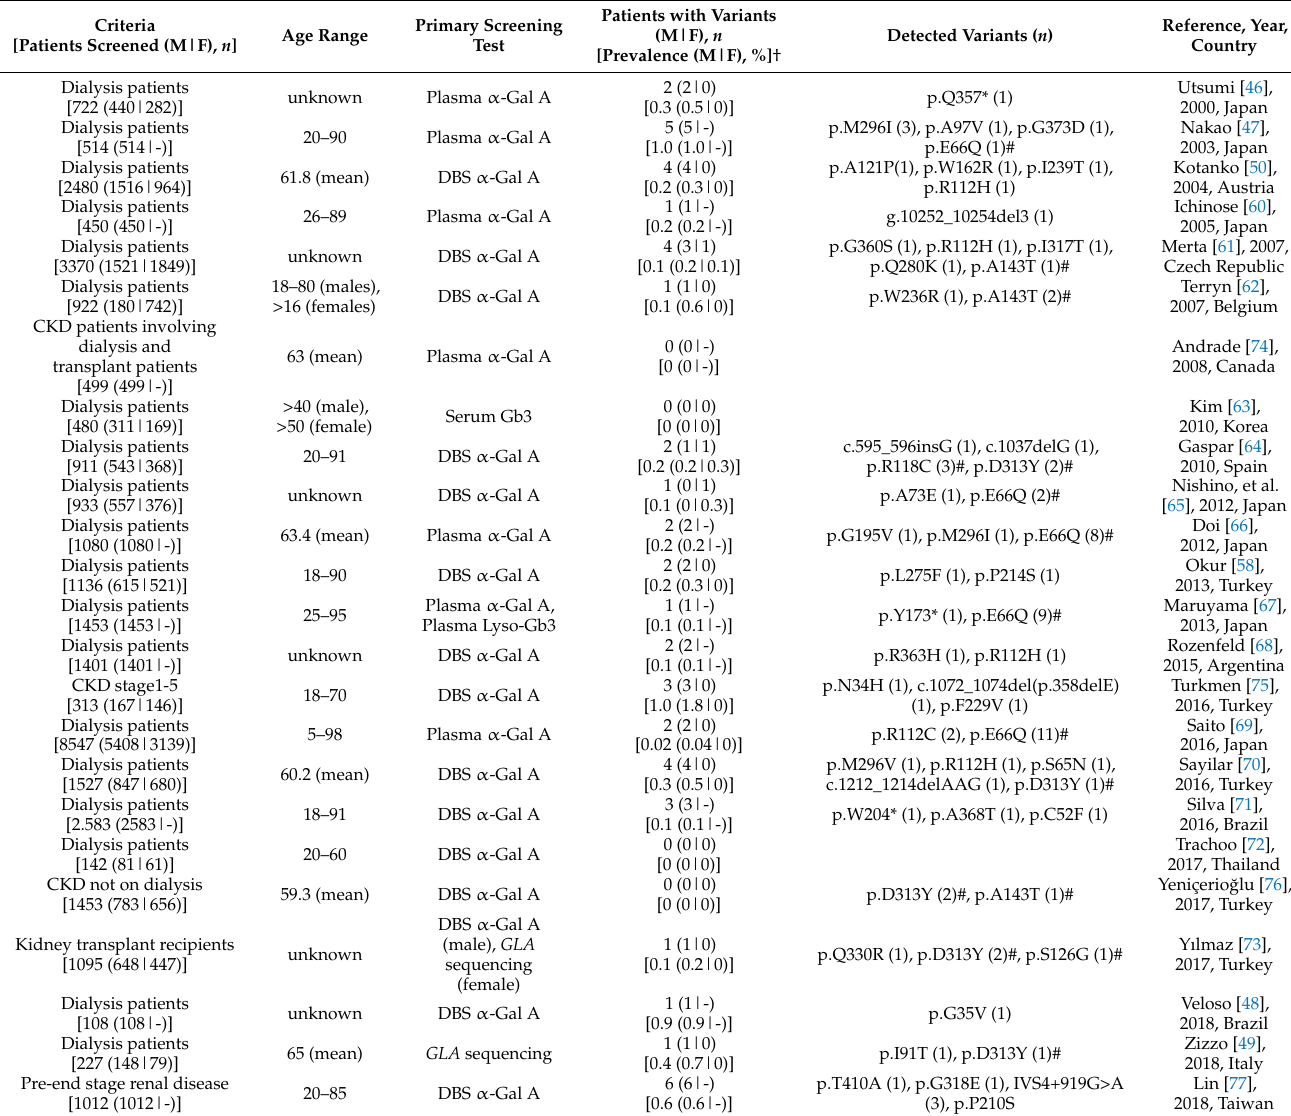
Table 1. Previous high-risk screening for FD in individuals with renal manifestations. Patients with Variants Primary Screening (M|F), Test